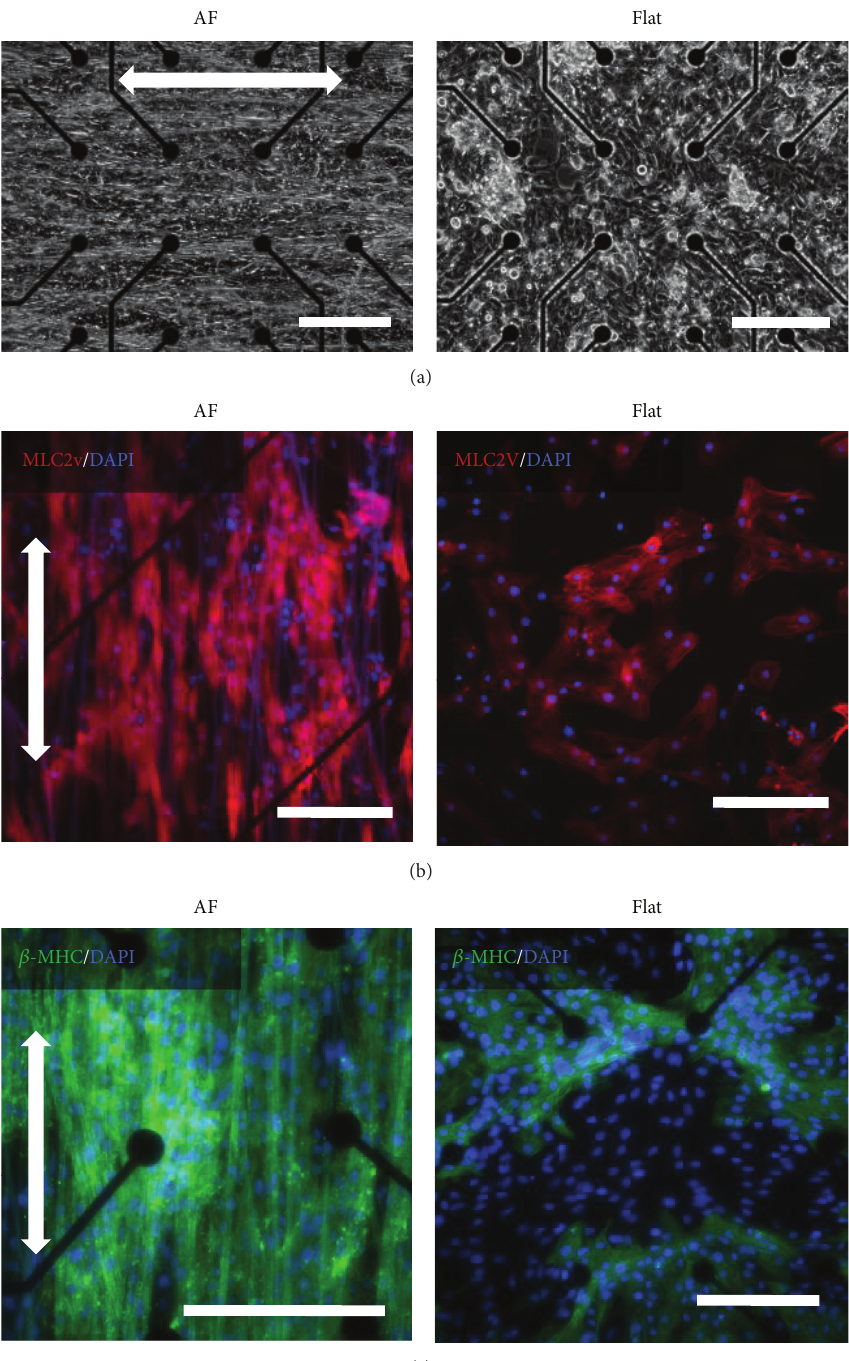
Figure 3: IMR hiPS-cardiomyocytes (CMs) cultured on aligned fiber (AF)-coated and gelatin-coated (Flat) microelectrode arrays (MEA). (a) Phase contrast images of CMs plated on the MEA for 2 days: the scale bar in = 200 𝜇 m. (b, c) Fluorescence images of CMs cultured for 14 days on MEA. (b) MLC2v is shown in red, (c) 𝛽 -MHC in green, and DAPI in blue. The scale bar = 200 𝜇 m. The color on fiber is due to autofluorescence of PMGI. White arrow marked the fiber